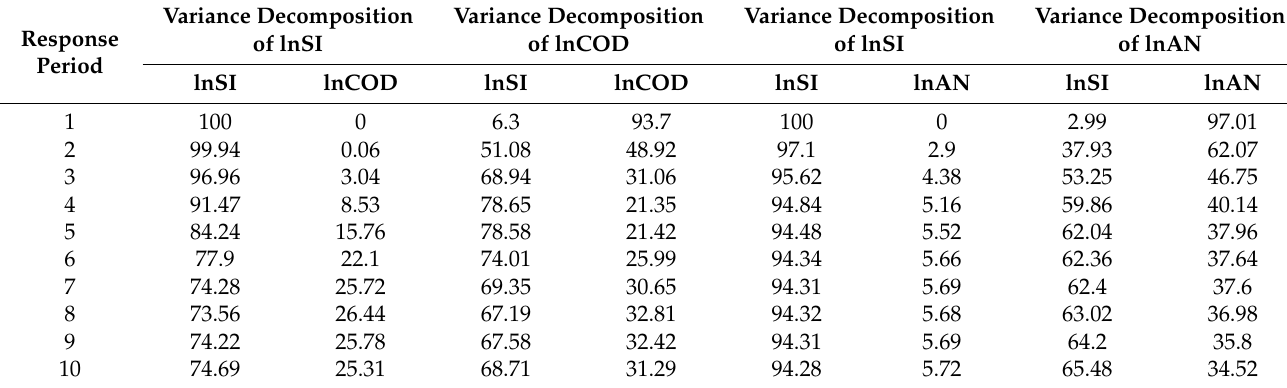
Table 5. Forecast variance decomposition of the discharge of pollutants to the aquatic environment in response to industrial structure adjustment in